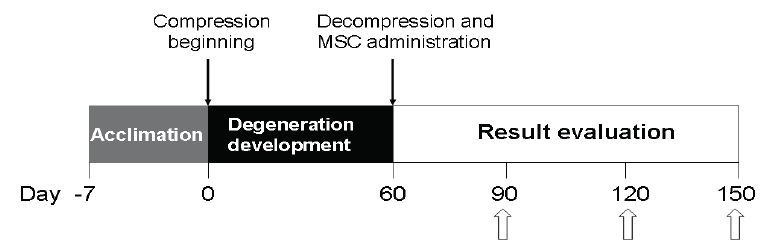
Figure 1. Experimental schedule. White arrows denote time points at which histomorphometric analysis of the AF tissue was